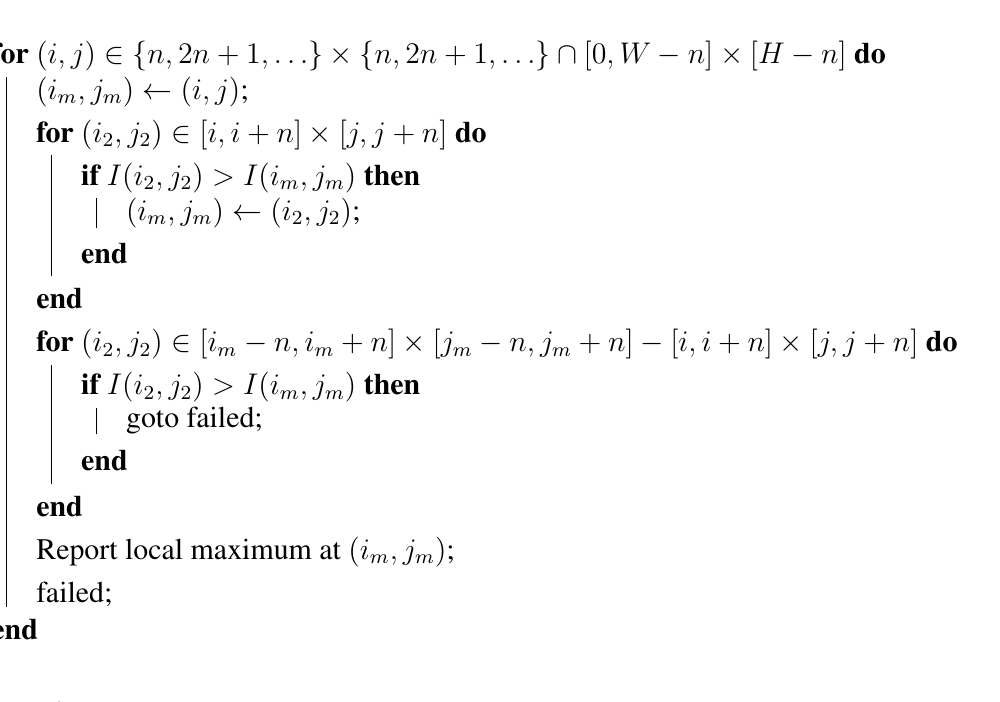
Algorithm 1: Non-maximal suppression in 2 dimensions proposed in